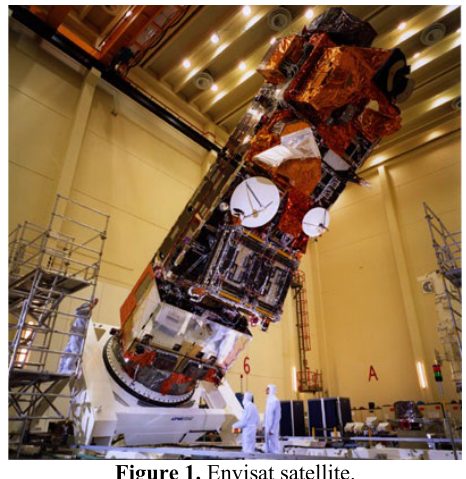
Figure 1. Envisat satellite.